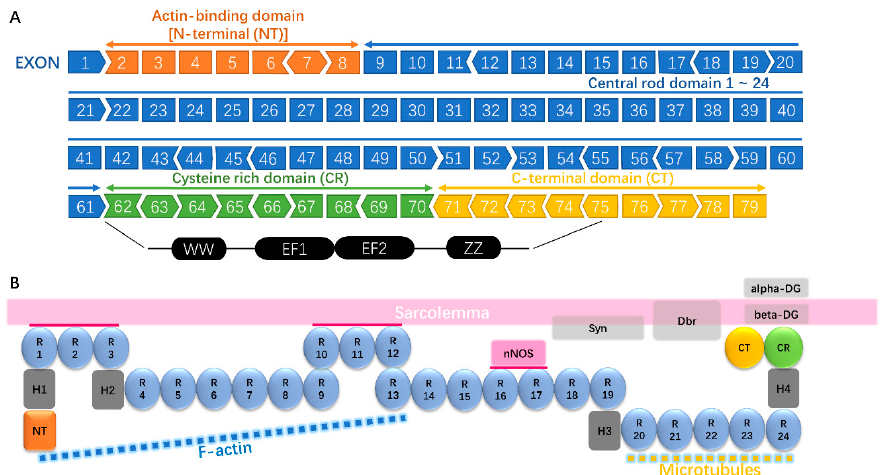
Figure 1. Dystrophin gene with exon mutation spots and their corresponding domains. ( A ) The structure of dystrophin gene. Dystrophin gene contains 79 exons. N -terminal domain (NT): exon 2–8; Central rod domain: exon 9–61; Cysteine-rich domain (CR): exon 64–70; C-terminal domain (CT): exon 71–79. The arrow shape of the adjacent exons shows open reading frame (ORF) compatibility. The CR and CT domains comprise the WW domain, EF hand and ZZ domains. ( B ) The schematic of dystrophin protein structure and dystrophin-sarcolemma interaction. In skeletal muscle, central rod domain 1–3 and 10–12, CR, CT binds to the sarcolemma, termed membrane binding domains (MBDs). In cardiac muscle, R10–12 do not bind to the sarcolemma. The N -terminal domain contains the primary actin binding domain which connects F-actin. The CR and first half of the CT bind to transmembrane β -dystroglycan. CT contains the dystrobrevin- and syntrophin-binding sites, which bind to the two transmembrane proteins on sarcolemma. The NT, CR, and CT are considered essential for dystrophin function. R: rod domain. H: hinge.